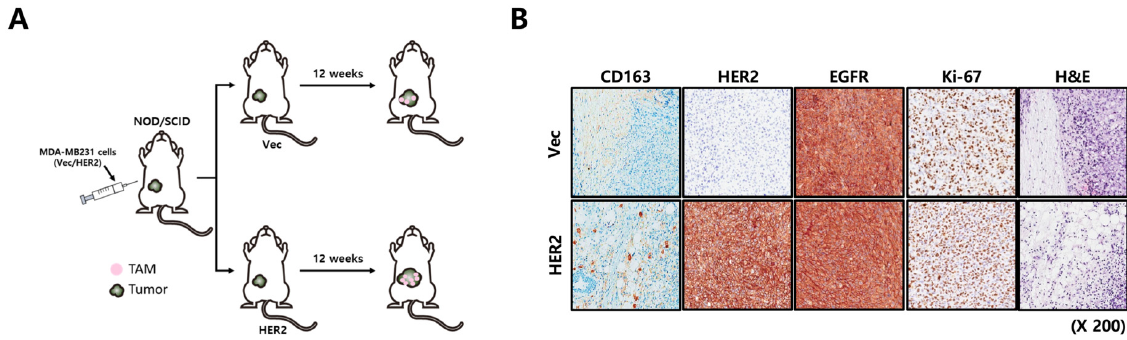
Figure 6. TAMs recruited into HER2-overexpressed tumors. ( A ) A schematic diagram illustrating the xenograft study in this figure: MDA-MB231 Vec or HER2-overexpressed cells were injected into the 2nd fat pad of NOD/SCID mice. Recruited TAMs were monitored after 12 weeks. ( B ) Recruited TAMs were analyzed using CD163 staining.